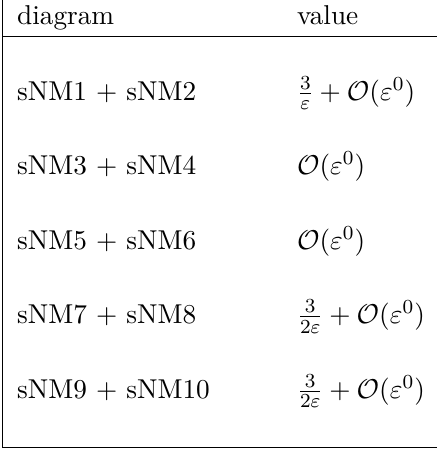
2 S (¯ x t − ¯ y t ) 0 (4 π ) 2